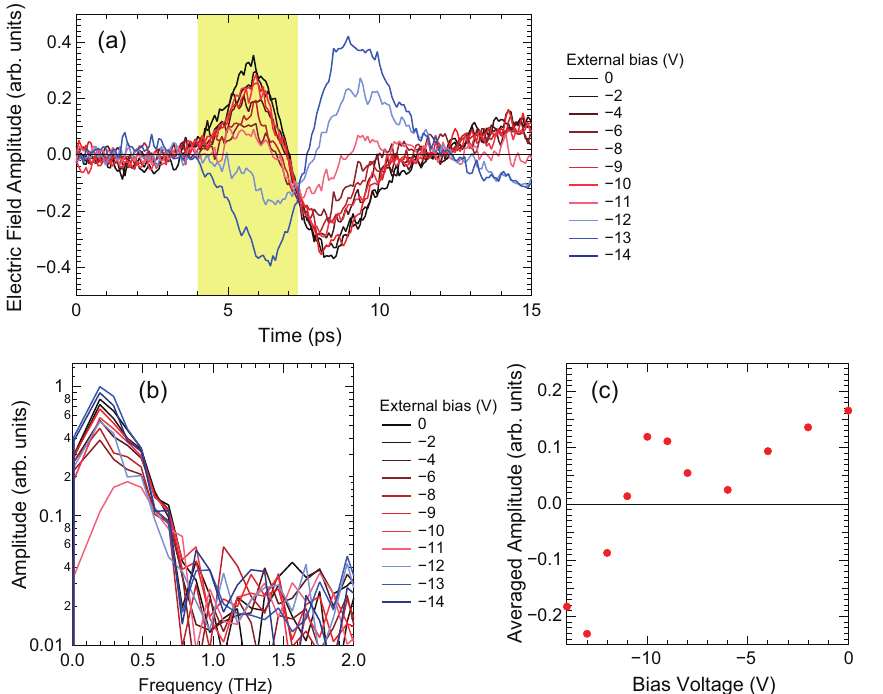
Figure 3. ( a ) Waveforms and ( b ) FFT amplitude of the THz radiation at various bias voltages from 0 to − 14 V and ( c ) THz radiation amplitude averaged over the first peak period, shown in the yellow rectangle in ( a